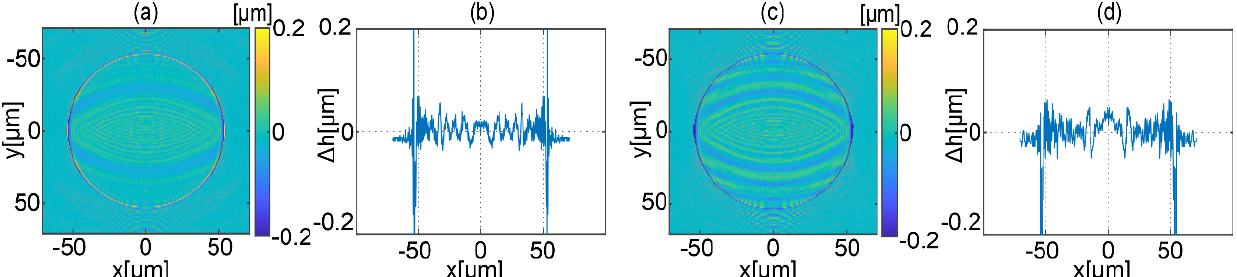
Figure 4. Numerical LSFs for a 3D micro focusing object when using different illumination scanning strategies: ( a ) horizontal and ( b ) vertical cross-section for equally angle spaced strategy, respec- Figure 5. Comparison of the shapes of the simulated and reconstructed object: ( a ) shape difference tively; ( c ) horizontal and ( d ) vertical cross-section for geometrically frequency spaced strategy. map and ( b ) corresponding horizontal cross-section for equally angle spaced strategy, ( c ) shape dif- ference map and ( d ) horizontal cross-section for geometrically frequency spaced strategy.